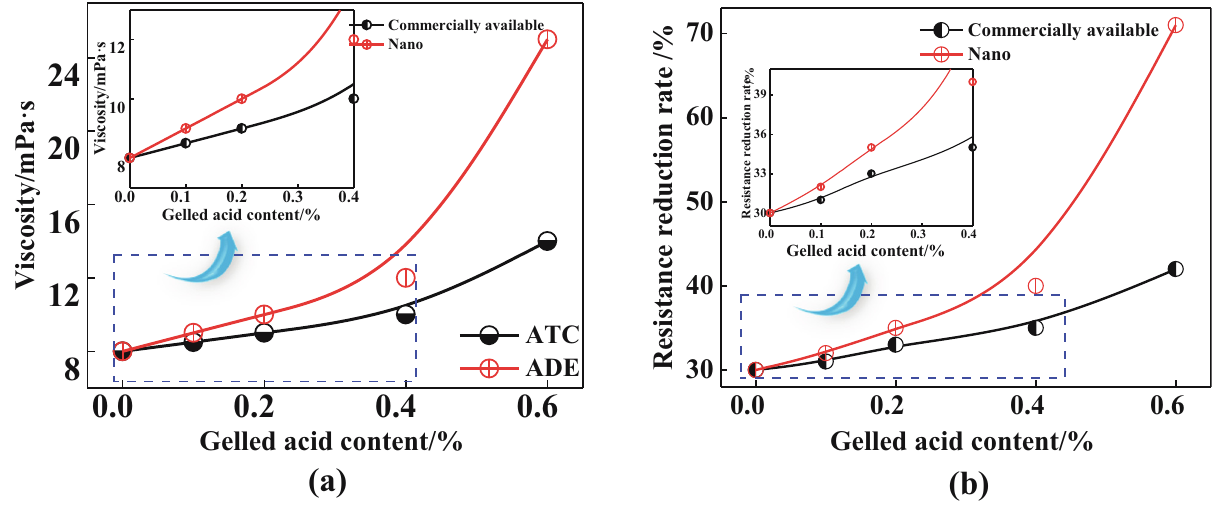
Figure 4: In fl uence of gelling agent addition on acid viscosity, friction - reducing rate, and fi ltration coe ffi cient. ( a ) E ff ect of chemical content on fl uid viscosity; ( b ) e ff ect of chemical content on resistance reduction rate.